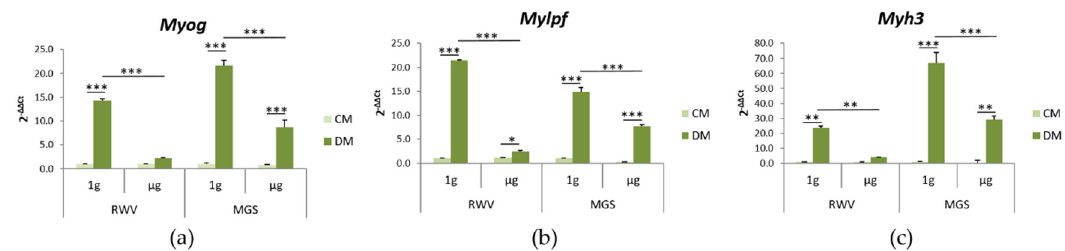
Figure 5. Mouse skeletal C2C12 myoblasts were cultured both in the RWV and in the MGS or in 1 g-ground control for 4 days. RT-PCR was performed three times in triplicate on RNA extracted using primers designed on Myog ( a ), Mylpf ( b ), and Myh3 ( c ) sequences. * p ˂ 0.05; ** p ˂ 0.01; *** p ˂ 0.001.